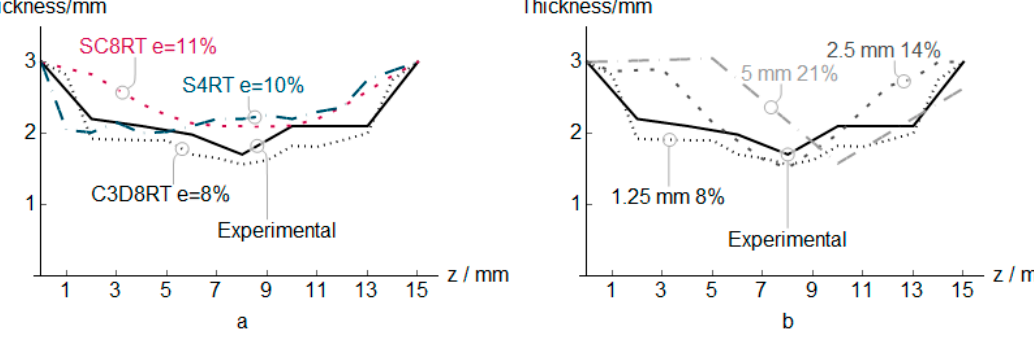
final shape. The smallest error was obtained by C3D8RT elements with a mean deviation of 0.3 mm. The shell elements and the C3D8RT with an element length of 5 mm show the highest